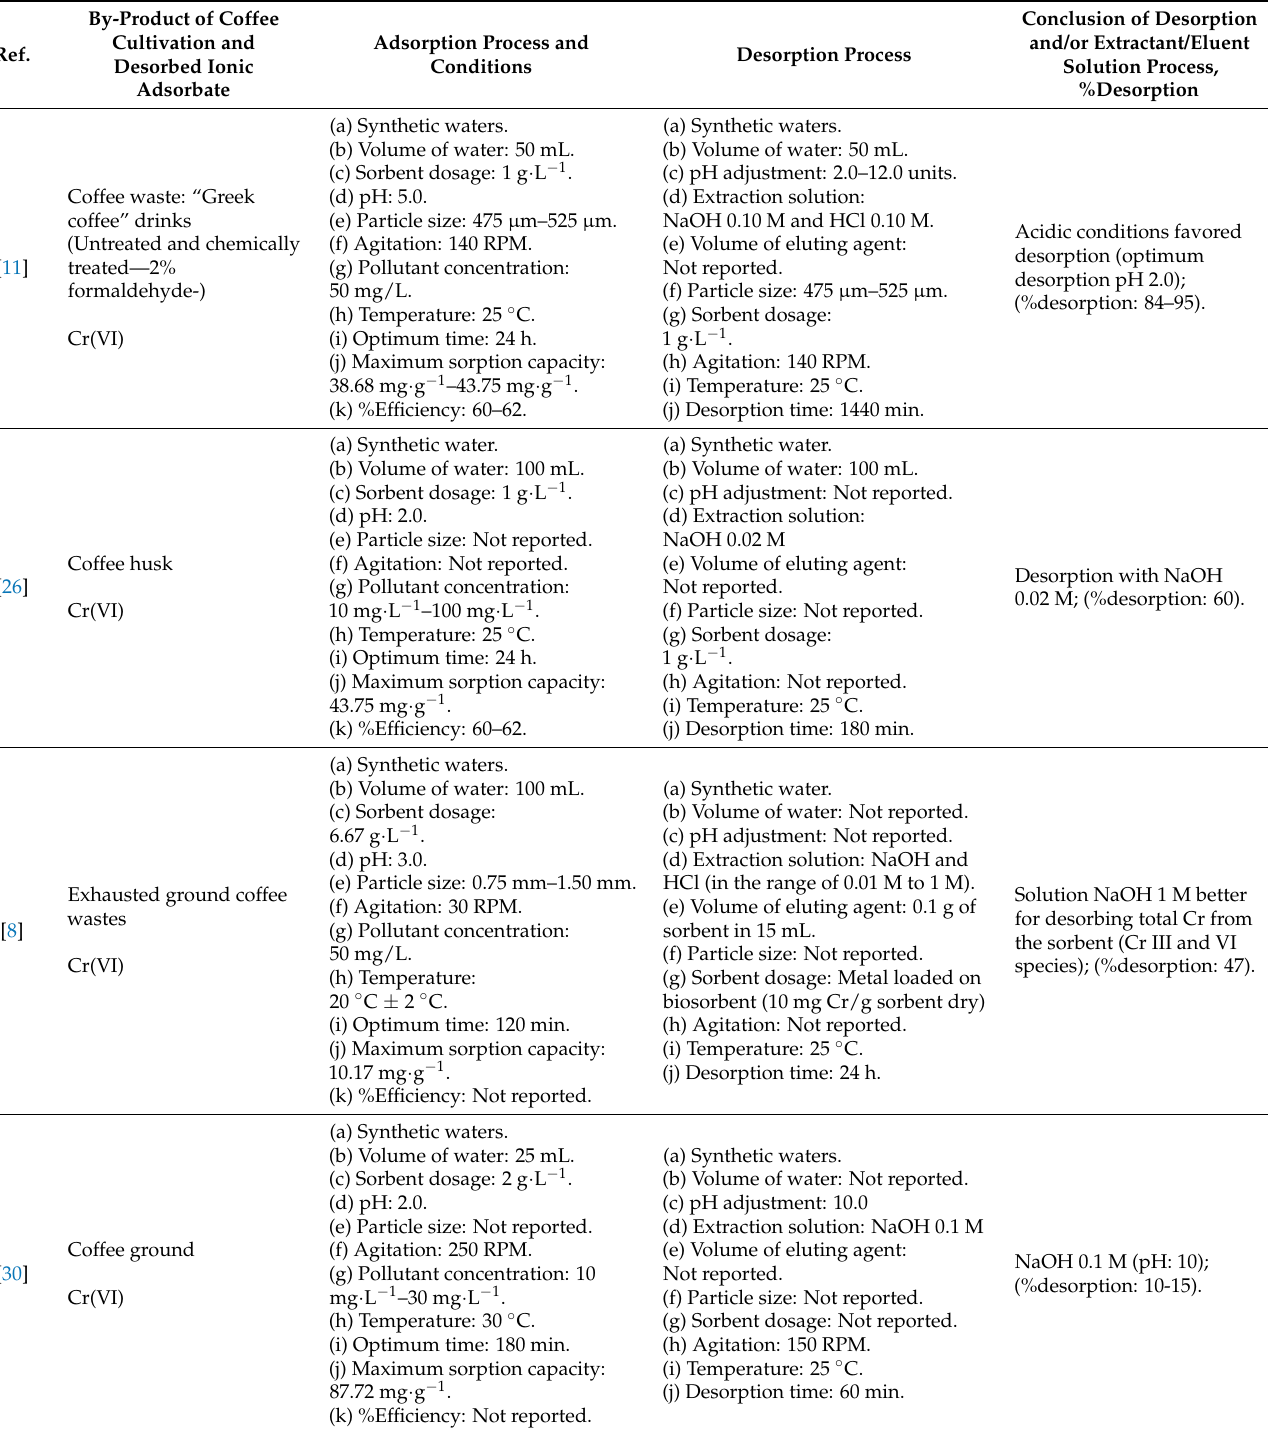
Table 5. Sorption and desorption processes and conditions with various by-products derived from coffee